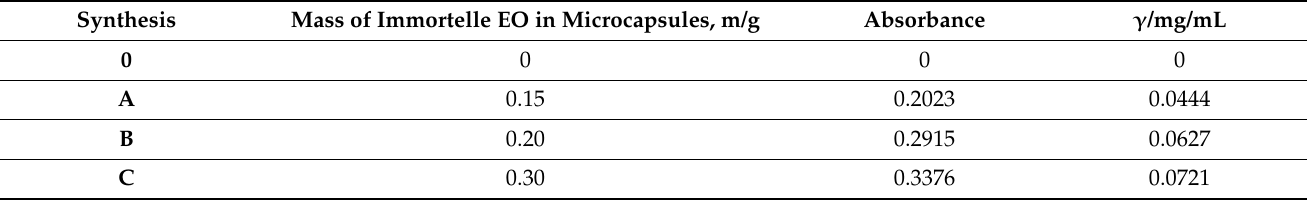
Table 3. The calculated concentration of microcapsules and measured absorbance. Synthesis Mass of Immortelle EO in Microcapsules, m/g